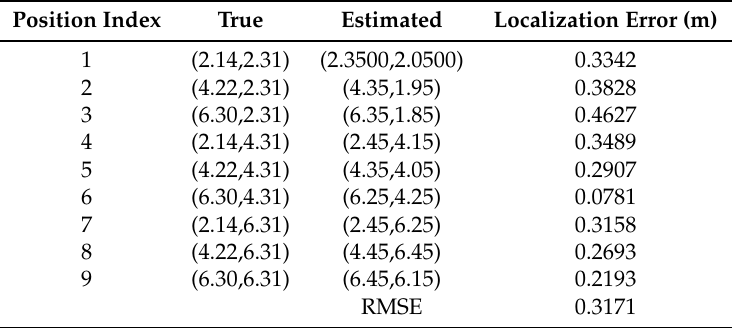
Table 2. Localization Results of